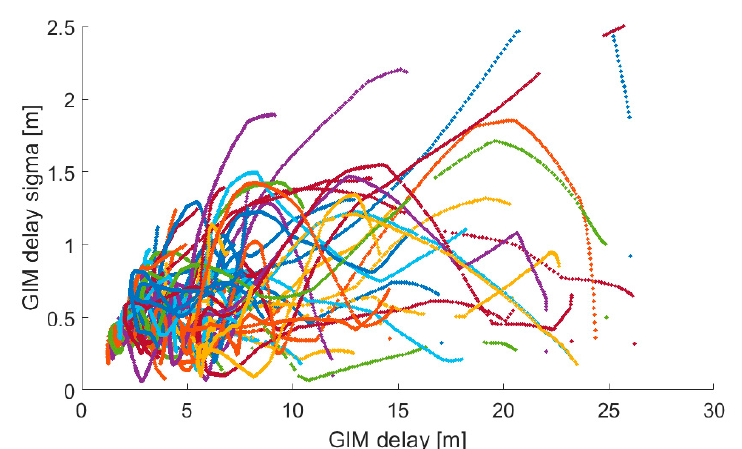
Figure 4. Correlation between GIM delays and their sigmas. Correlation coefficient equals 0.52. Each colour marker point represents a particular satellite. Delays are shown for DOY 253, 2018 for GMSD station, located in Japan.